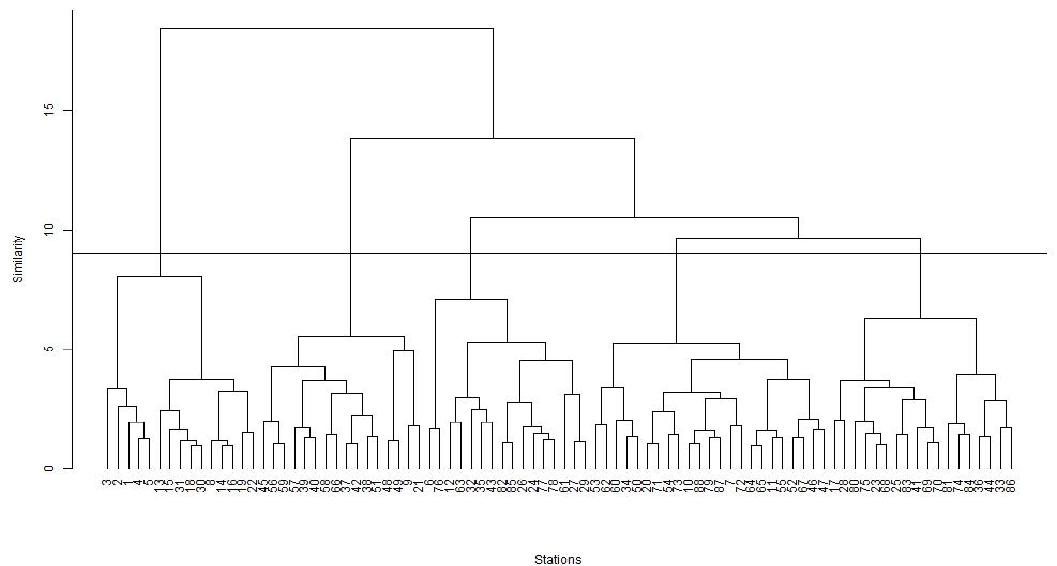
Figure 6. Result of Ward’s hierarchical clustering method by using eight selected catchment characteristics (dendrogram). Figures 7 and 8 show the boxplots representing the distribution of the eight predictors for the clusters. Figure 7 shows the boxplots for ‘ A ’, ‘ I 62 ’, ‘ SF ’, and ‘ sden ’ and Figure 8 shows the boxplots for ‘ MAR ’, ‘ MAE ’, ‘ S1085 ’, and ‘ forest ’. From Figures 7 and 8, it can be said that the stations in cluster 1 have the smallest catchment area range with the largest design rainfall intensity, as well as larger ‘ MAR ’ and ‘ MAE ’ values. These stations seem to have higher percentages of forest areas as well as along with higher stream density. Stations in cluster 2 have moderate catchment areas, along with ‘ I 62 ’, ‘ SF ’, ‘ sden ’, and ‘ MAR ’. However, the ‘ MAE ’ is the highest in case of cluster 2. Cluster 3 seems to have all the predictors relatively uniformly distributed. Cluster 4 is characterized by medium catchment area, smaller ‘ I 62 ’, ‘ SF ’, ‘ sden ’, ‘ MAR ’, ‘ MAE ’, ‘ S1085 ’, and ‘ forest ’. The largest area is found for cluster 5, although the other predictors are quite small with large variance in fraction forest